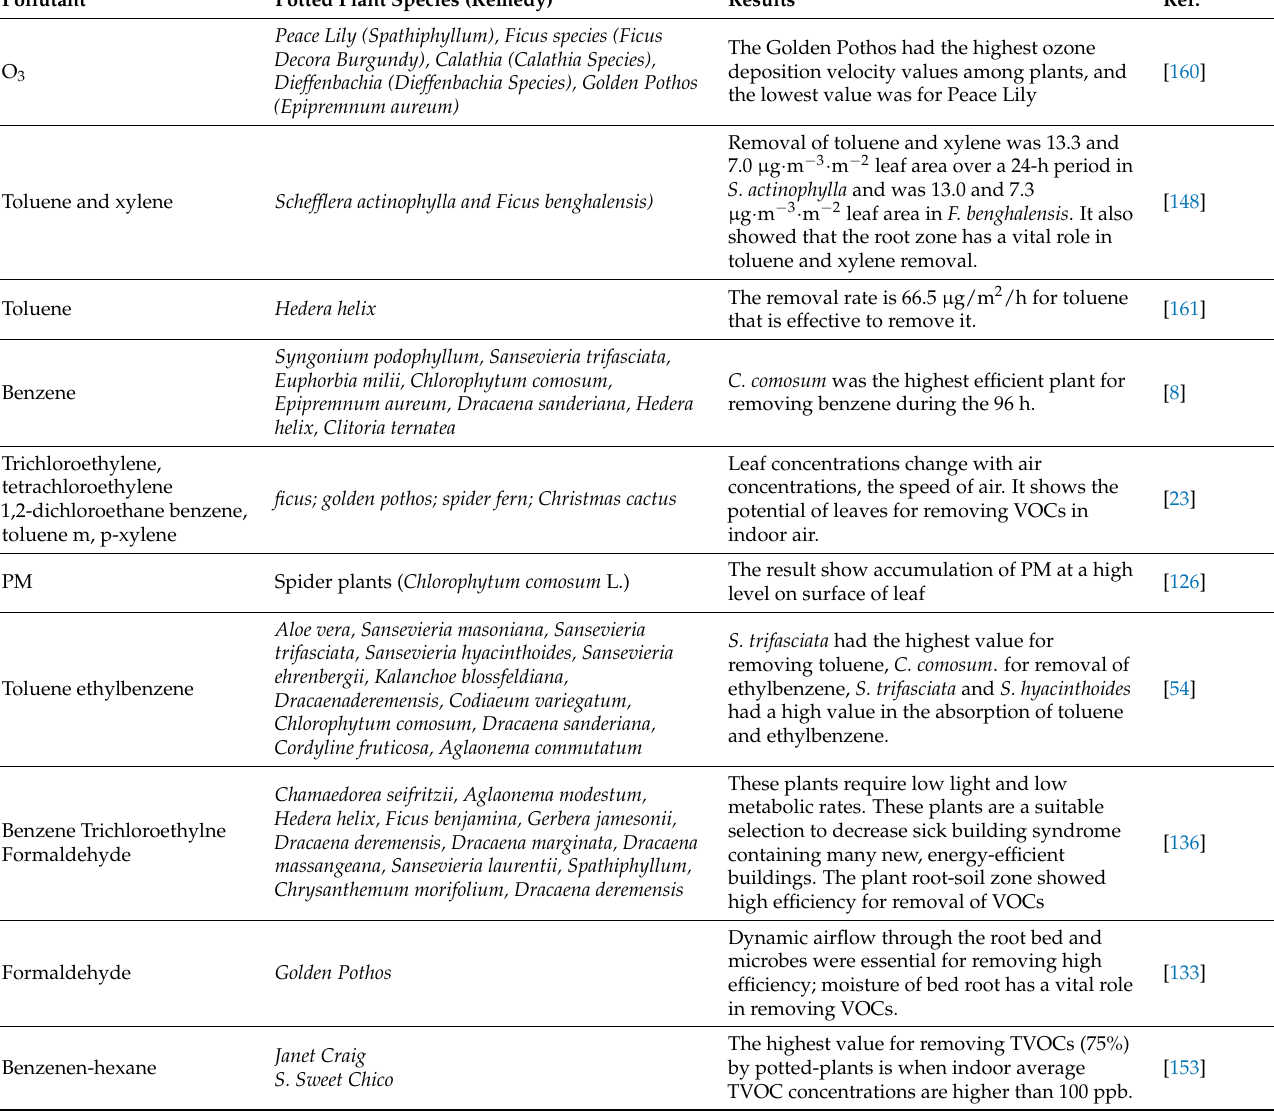
be used for removal of formaldehyde (CH 2 O), Spider plant (Chlorophytum comosum), Janet Craig Dracaena (Dracaena deremensis ‘Janet Craig’), Ficus sp. for removal of carbon monoxide (CO), Golden Pothos (Epipremnum aures), Devil’s ivy (Epipremnum aureum), Philodendron for removal of VOCs, Mother-in-law’s tongue (Sansevieria trifasciata ‘Laurentii’) Chrysanthe- mum (Chrysantheium morifolium), Dracaena sp. for removal of trichloroethylene (TCE), and Kimberly Queen Fern (Nephrolepis obliterate), Orchid sp. ( Phalaenopsis sp.) Dieffenbachia sp. for removal of benzene (C 6 H 6 )/toluene (C 7 H 8 )/xylene (C 8 H 10 ) [95]. Table 3 illustrates some of the studies focusing on the removal of pollutant from indoor air. The potted-plants that were used for VOC removal are Dracaena deremensis var. “Janet Craig” (Dracaenaceae) and Spathiphyllum wallissii var. Petite (Peace Lily). These plants are the type of common tropical house plants and they do not have high efficiency in pollutant removal. Plants with excellent efficiency are Hemigraphis alternata (Purple waffle), Tradescantia pallida (Purple heart), Hedera helix (English Ivy), Asparagus densiflorous (Asparagus fern), Hoya camosa (Variegated wax) and Crassula portulacea (Crassulaceae) [127]. Table 3. Research on indoor air cleaning using potted-plants organized based on pollutant to remove. Pollutant Potted Plant Species (Remedy) Results